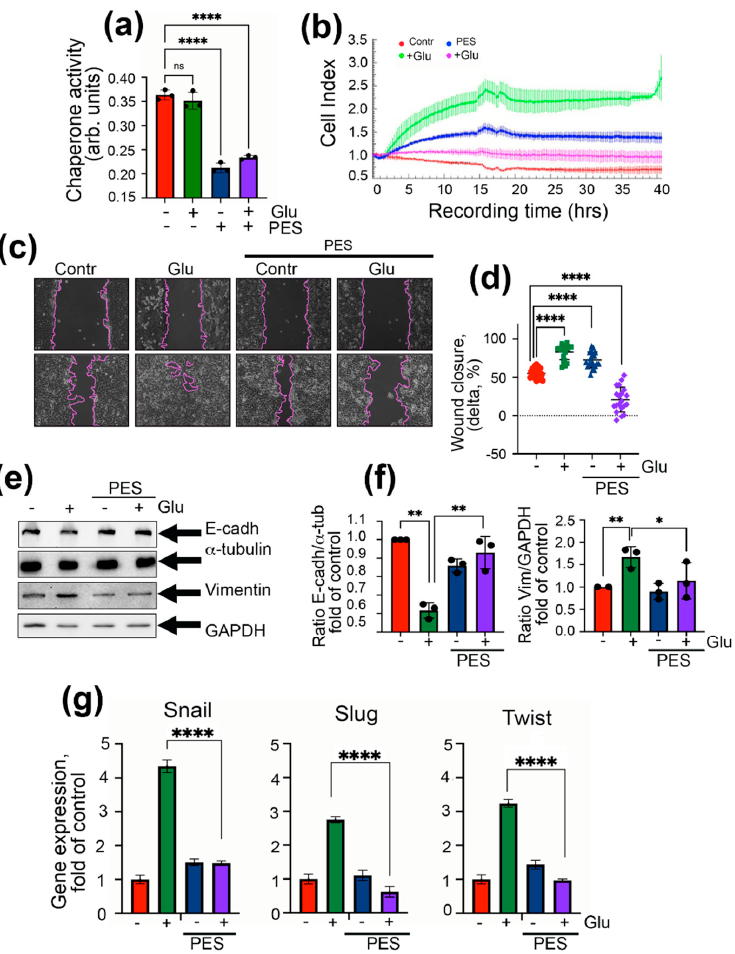
Figure 5. Inhibitor of Hsp70 function, PES (or pifithrin- µ ), reduces EMT in DLD1 cells in high glucose conditions. ( a ) Data of chaperone activity assay of cells treated with 3 µ M PES and 80 mM glucose. **** p < 0.0001. ( b ) After 6 days of incubation with 80 mM glucose and 3 µ M PES, DLD1 cells were seeded to 16-well CIM plates, and were then monitored with the aid of xCELLigence equipment over 40 h. ( c ) Wound healing assay of DLD1 cells treated as in ( d ) with calculation of % of delta between distance of cells at 0 and 24 h **** p < 0.0001. ( e ) Western blot of DLD1 cells treated with 3 µ M PES and 80 mM glucose probed with antibodies against E-cadherin and vimentin and ( f ) calculation of ratio of E-cadherin band intensity to a-tubulin band intercity as fold of control (left panel) and ratio of vimentin band intensity to GAPDH band intensity (right panel). ** p = 0.0015, 0.0029, 0.0065; * p = 0.0393. ( g ) qPCR data of Snail, Slug, and Twist in DLD1 cells treated with 3 µ M PES and 80 mM glucose. **** p <